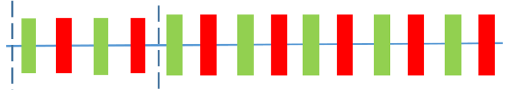
FIG. 4. Schematic plot of a FODO lattice used in the second application example. The four quadrupoles inside the dashed line box were used to match the initial distribution to the periodic FODO lattice.